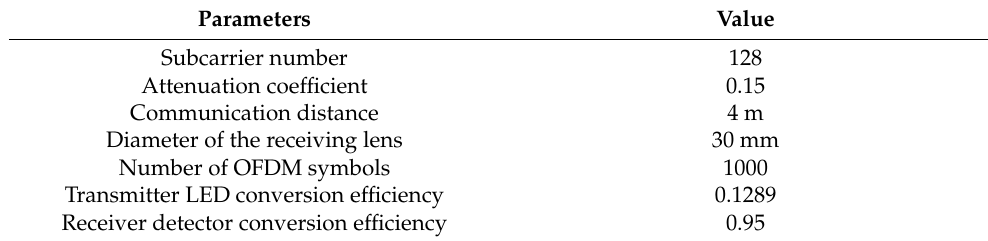
Table 2. Simulation parameters of the underwater optical Massive MIMO system.